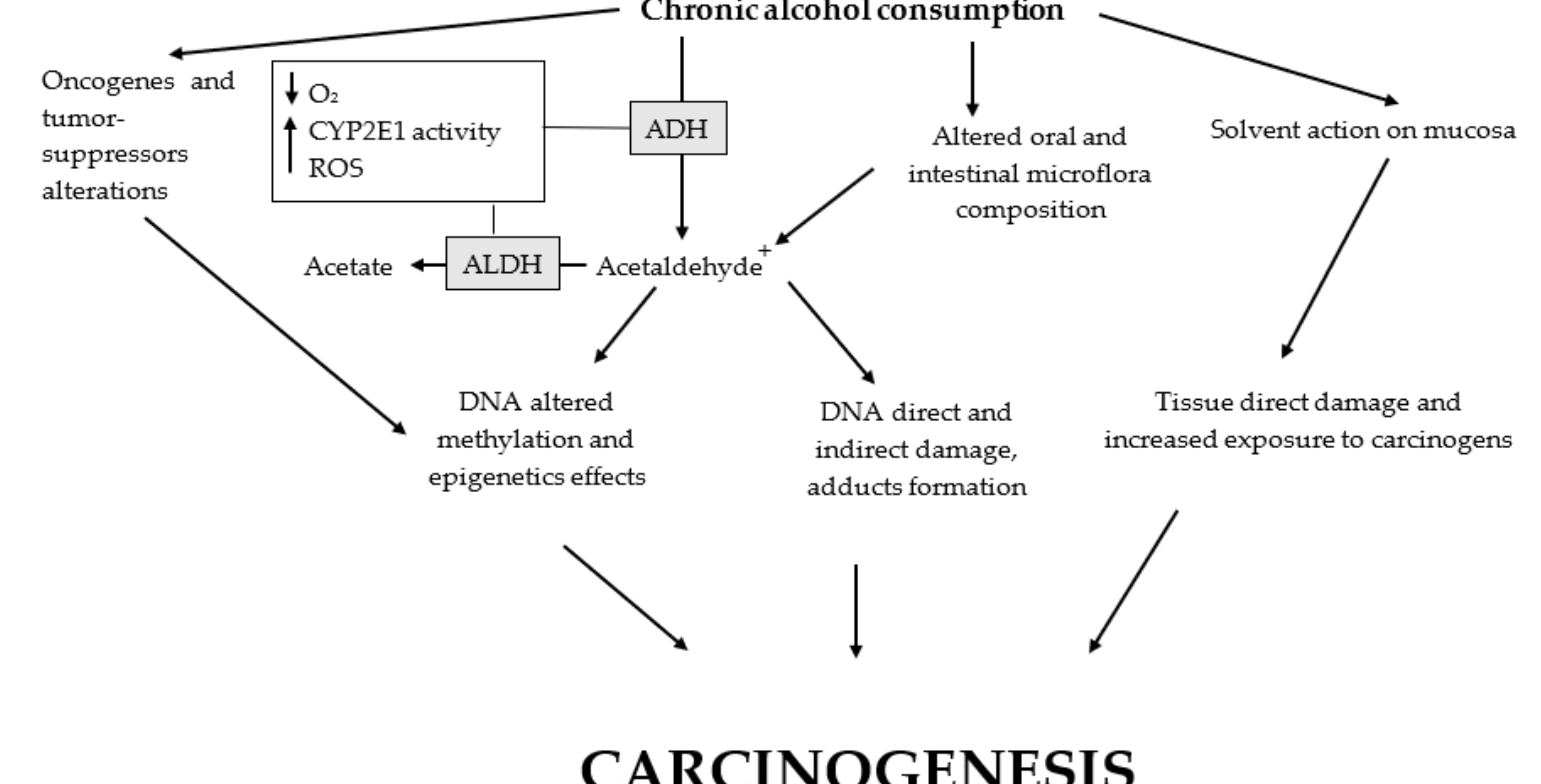
Figure 2. Main alcohol carcinogenic effects. Altered oral cavity and large intestine microflora, as well as polymorphisms of CYP2E1, ADH, and ALDH, promote